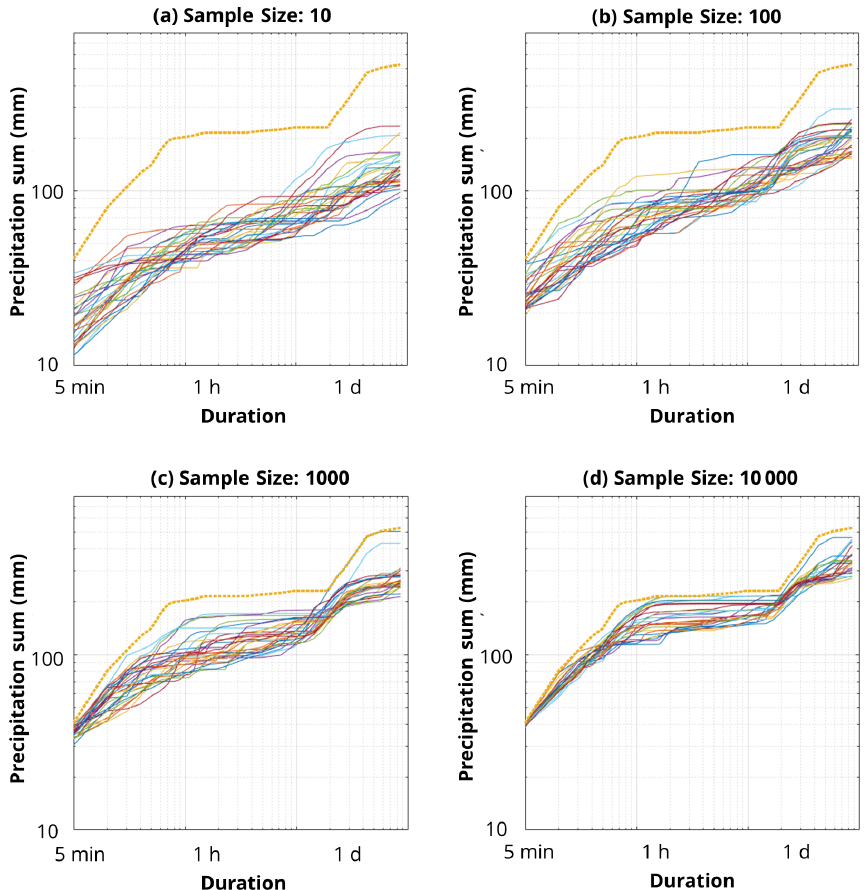
Figure 9. Dependency of maximum depth–duration relationship characteristic on underlying pixel sample size. The maximum rainfall values are derived from (a) 10, (b) 100, (c) 1000, and (d) 10000 random pixels from all considered pixels ( n = 392128) within Germany. For each sample size, 30 ensembles are displayed and compared to the overall maximum curve from Figs. 3 and 4 (yellow top